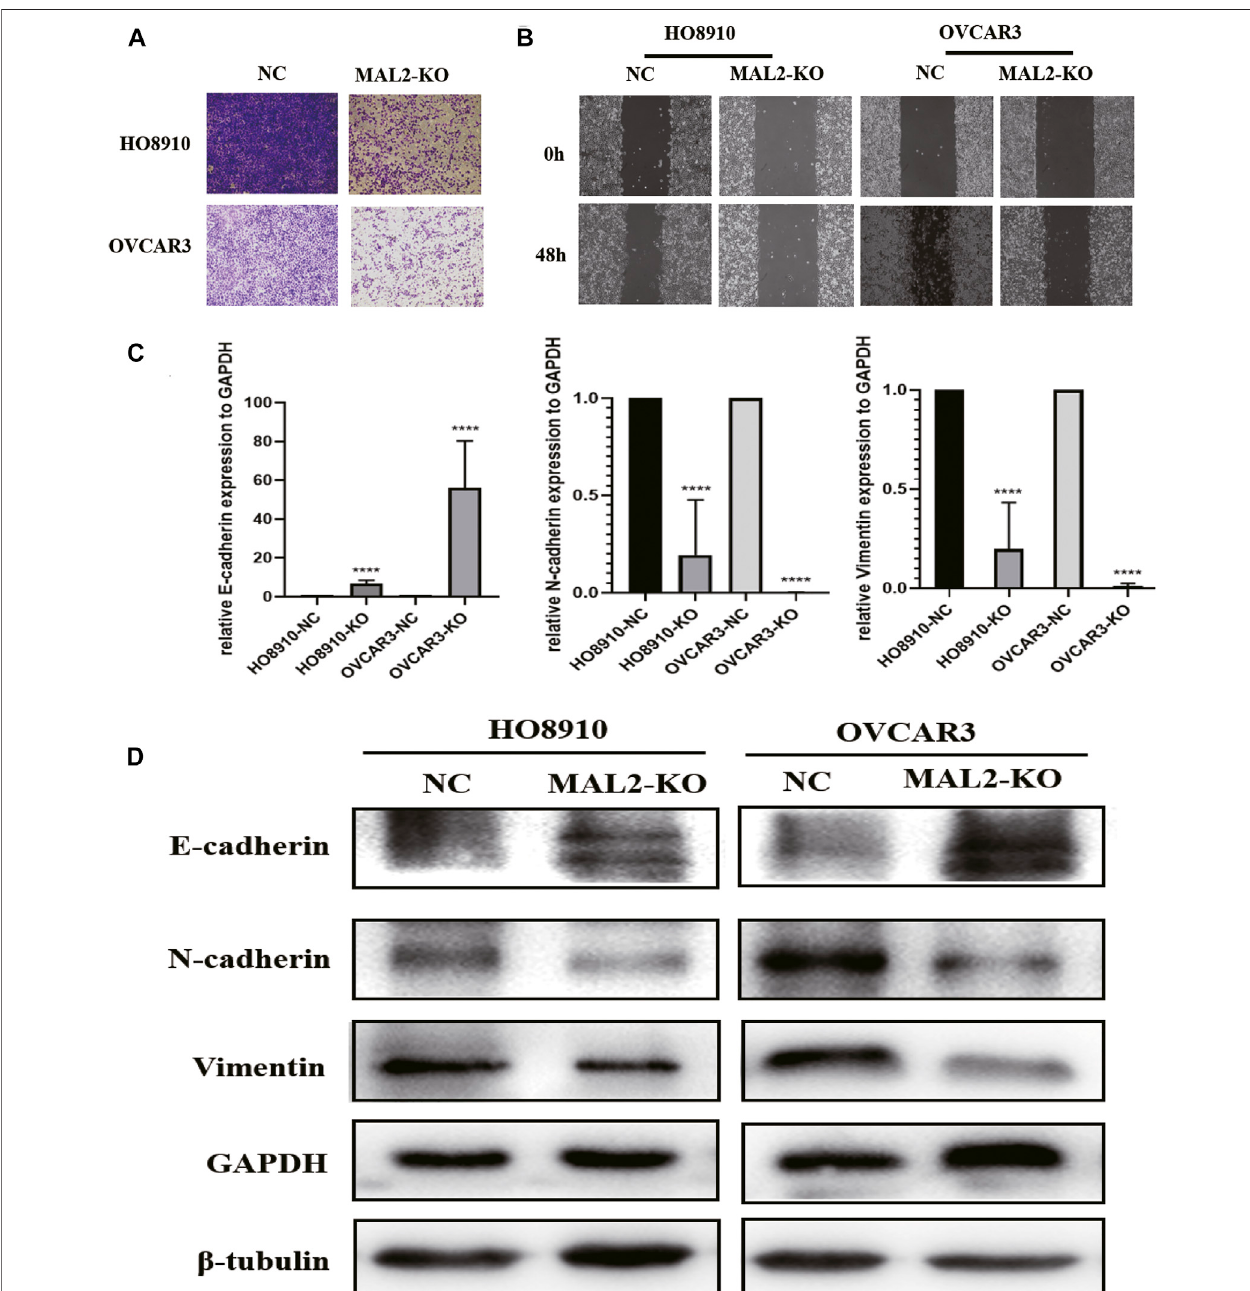
FIGURE 8 | Knockout of MAL2 in OC cells inhibits migration, invasion, and epithelial-mesenchymal transition (EMT). (A) Transwell migration assays in MAL2 knockout HO8910 and OVCAR3 cells and their corresponding negative control cells, with 8 × 10 4 cells per well. (B) Wound healing assays in MAL2 knockout HO8910 andOVCAR3cellsandtheircorrespondingnegativecontrolcells. (C) qRT-PCRanalysisoftheexpressionlevelsofE-cadherin,vimentin,andN-cadherininHO8910and OVCAR3 (KO or NC) cell lines. * p < 0.05; ** p < 0.01. (D) Western blotting analysis ofthe expression levels of E-cadherin, vimentin, and N-cadherin in HO8910 and OVCAR3 (KO or NC) cell